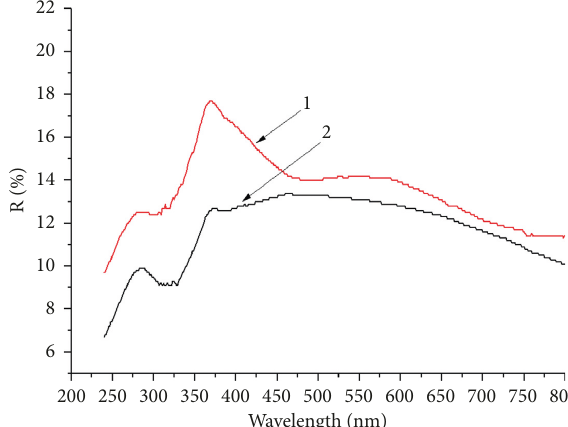
Figure 3: Spectral dependences of the reflection coefficient of PS samples: (1) initial PS; (2) irradiated PS doped with